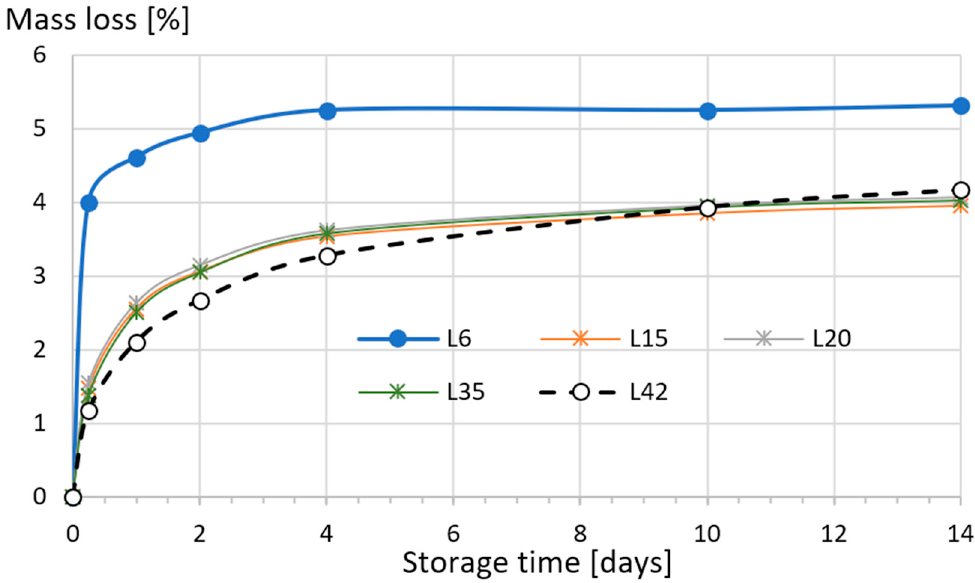
Figure 3. Mass loss of five laminates during 14 days of storage at 50 °C.